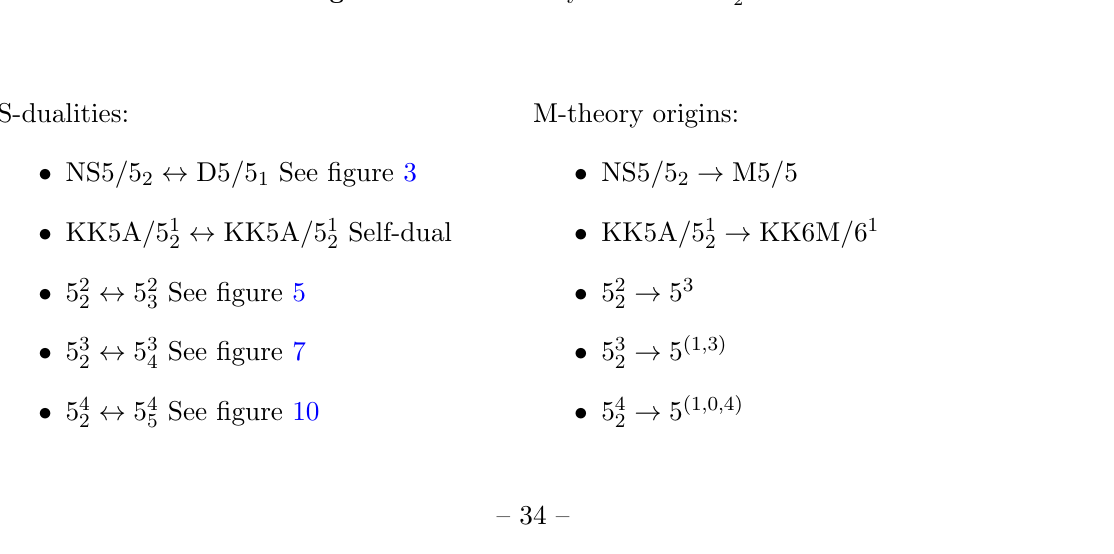
Figure 4 . The T-duality orbit of the 5 3